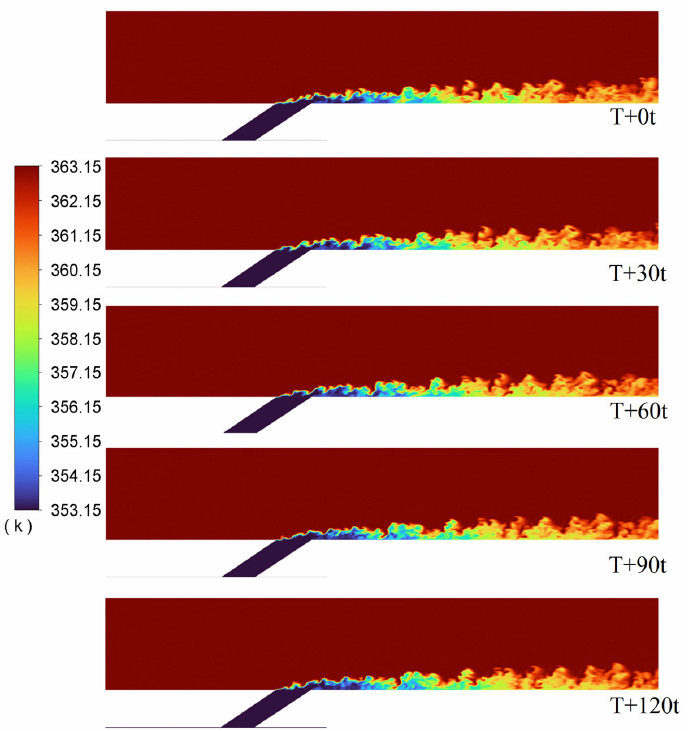
Figure 13. Instantaneous temperature distribution at different times on the central section of Case 3.